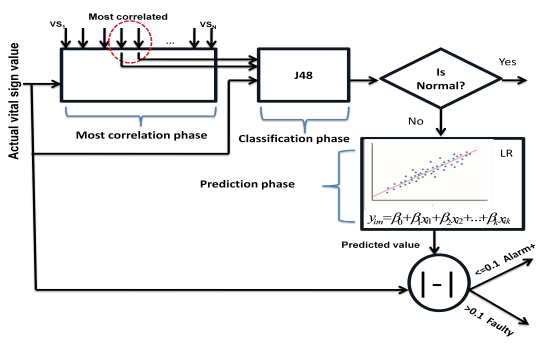
Figure 3. Our fault detection system in